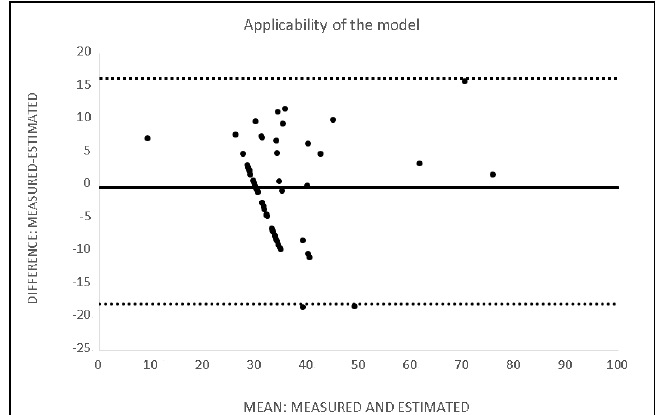
Figure 3. Bland and Altman plot describes the reliability of the model. The measured value is the value directly provided by using the Coach’s Evaluation, and the estimated value is the value ob- tained from the application of the